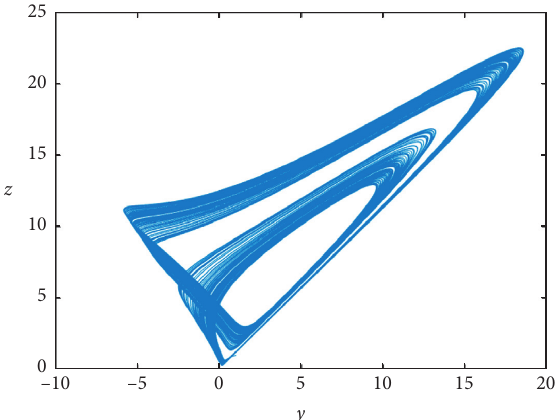
Figure 22: Dynamics of the fractional-order system in (13)–(15) with the order α � 0 . 92, in context of y and z